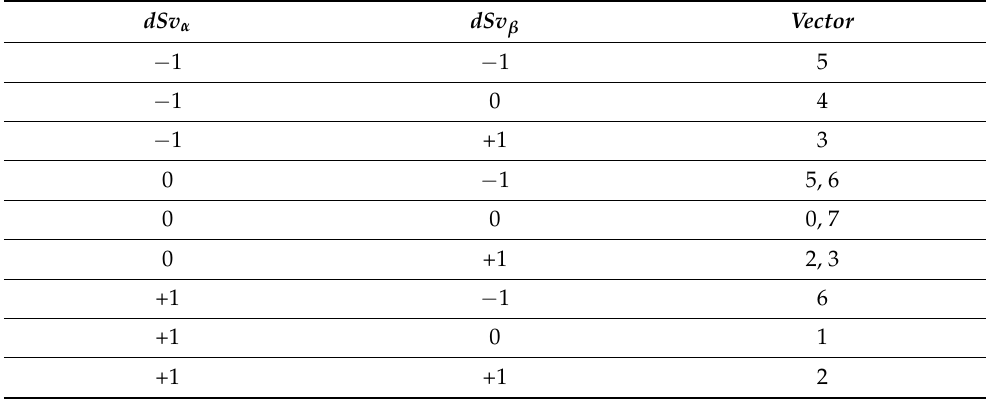
Table 1. Adopted Voltage Vectors Function of the Sliding Surfaces for Three-Leg Inverter.